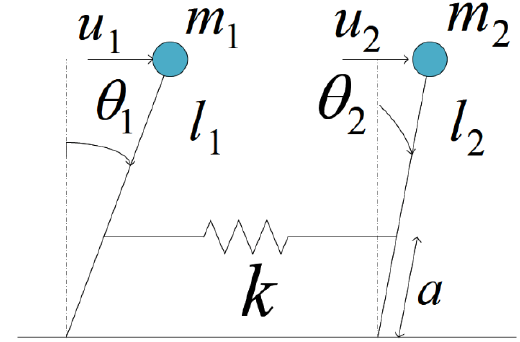
Figure 2. Two inverted pendulums coupled by a spring.